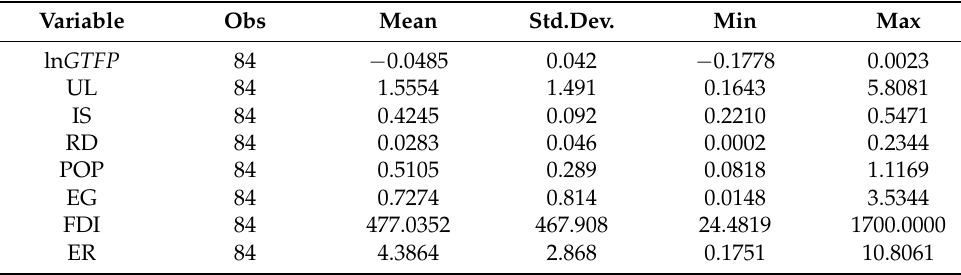
Table A3. Descriptive Statistics of Variables of the Southern China